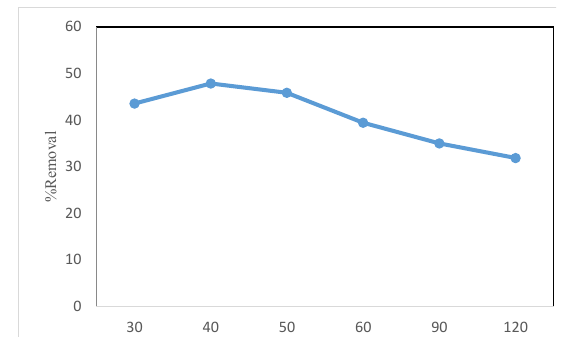
Fig. 2. The removal efficiency of Ni(II) by ferrous sulfate at different contact times (30,60,90, and 120 min) Fig. 3. The removal efficiency of Ni (II) by ferrous sulfate at different contact times (30, 40, 50, 60, 90, and 120 Figure 3. The removal efficiency of Ni (II) by ferrous sulfate Figure 2. The removal efficiency of Ni(II) by ferrous sulfate at different contact times (30, 40, 50, 60, 90, and 120 min) at different contact times (30,60,90, and 120 min)